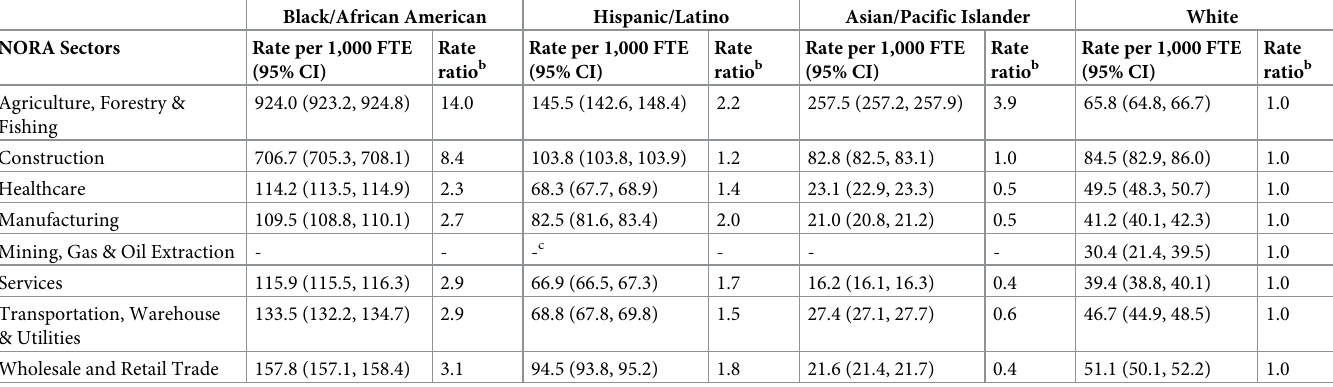
Sector ranging from 1.2 for compensable claims in Construction, to a rate ratio of 2.2 in Agri- culture, Forestry and Fishing. Asian/Pacific Islanders had similar or lower rates compared to Whites in all NORA sectors, except for Agriculture, Forestry, and Fishing (rate ratio 3.9). Table 3 provides rates by two-digit 2010 Standard Occupational Classification (cross walked from 2010 Bureau of Census (BOC) codes). Table 3 rate ratios are similar to the industry level rate ratios presented in Table 2, with Black/African Americans having the highest rates and rate ratios (compared to Whites) across all occupational groups, followed by Hispanic/Latino workers. Overall, Asian/Pacific Islanders had lower rates by occupation than Whites. Table 2. Rates of accepted workers’ compensation claims by estimated race/ethnicity and NORA industry sectors a